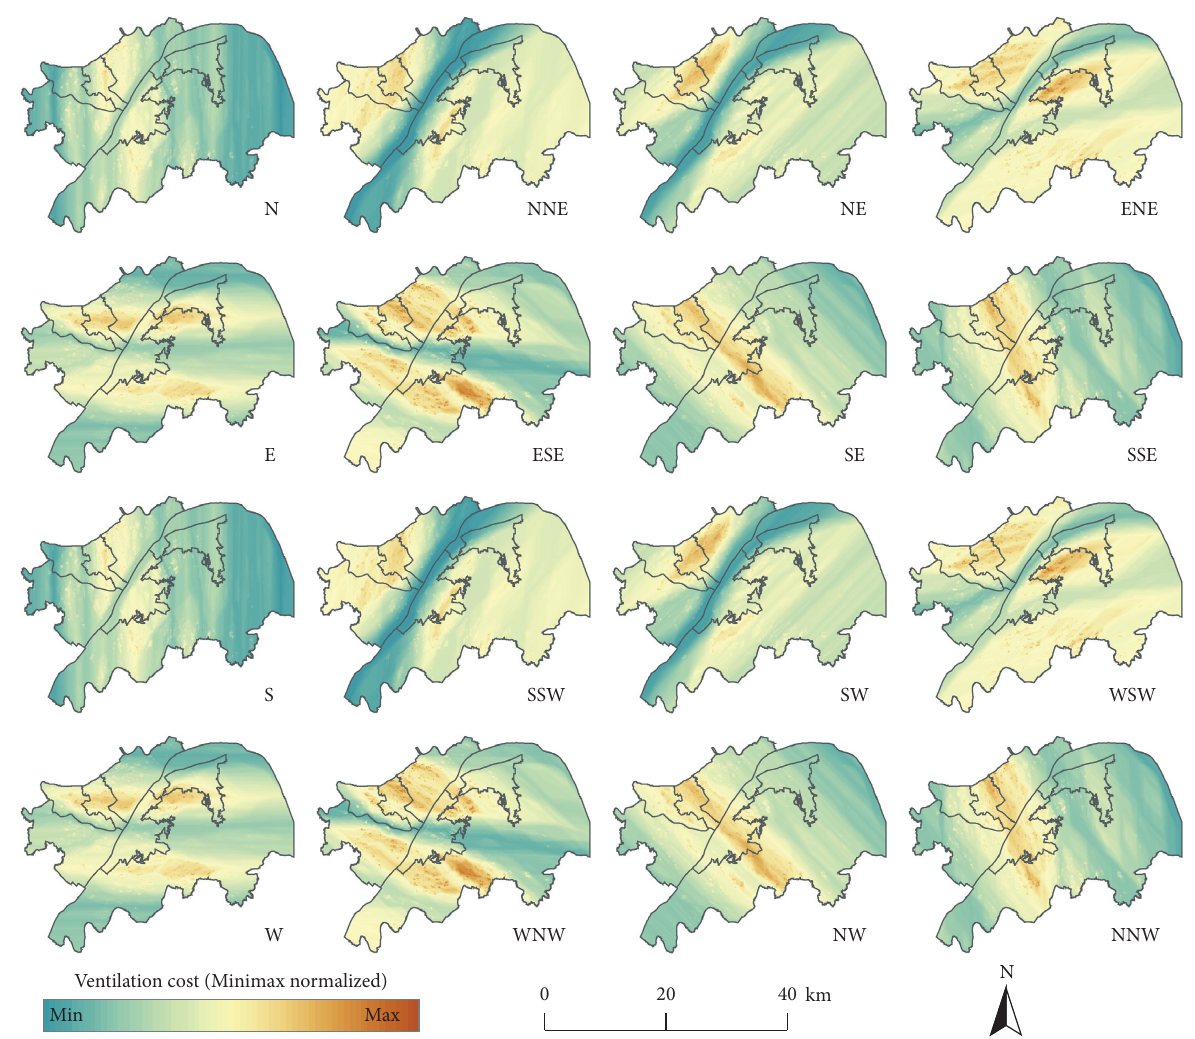
Figure 6: Spatial distribution of LCVC in different wind